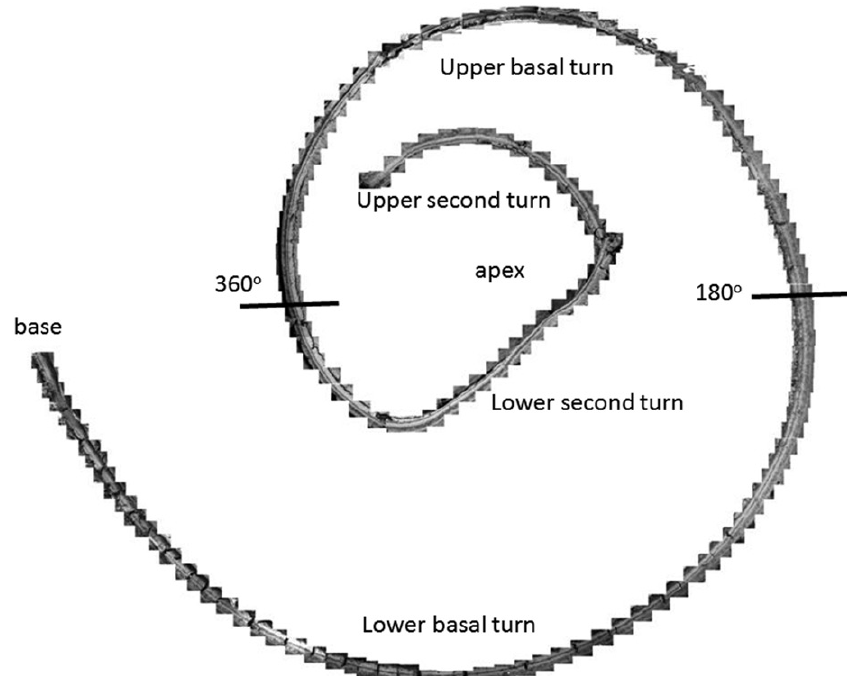
Figure 2. Composite SEM micrographs of the organ of Corti (specimen 1).